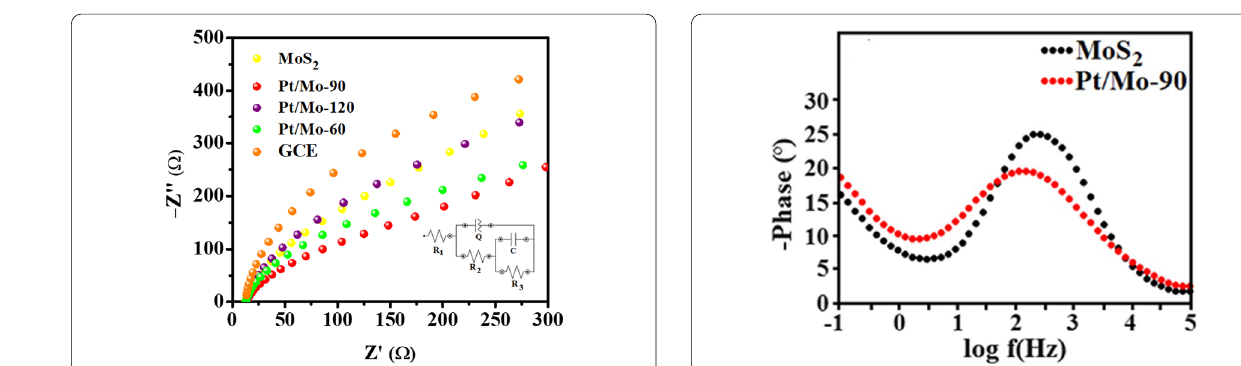
Fig. 9 Bode EIS plots of the pure MoS 2 and Pt/Mo-90